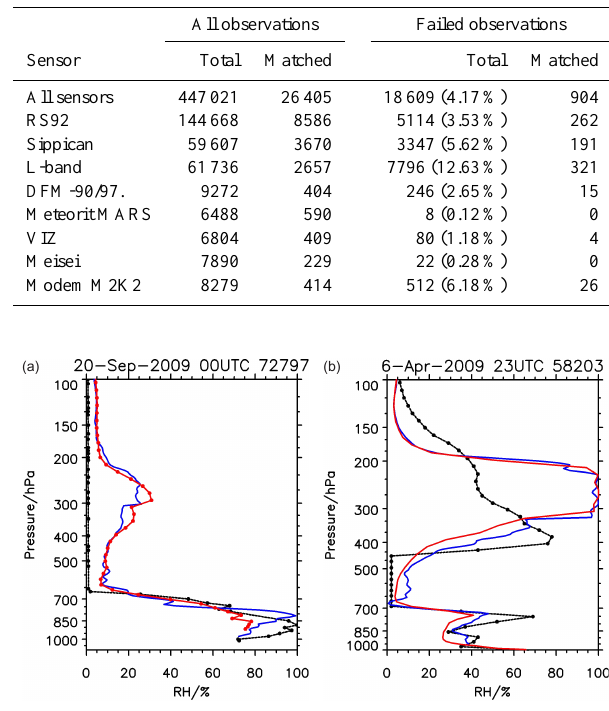
Table 2. Statistics of the total and failed relative humidity obser- vations matched with COSMIC data for different sensors from De- cember 2008 to November 2009.